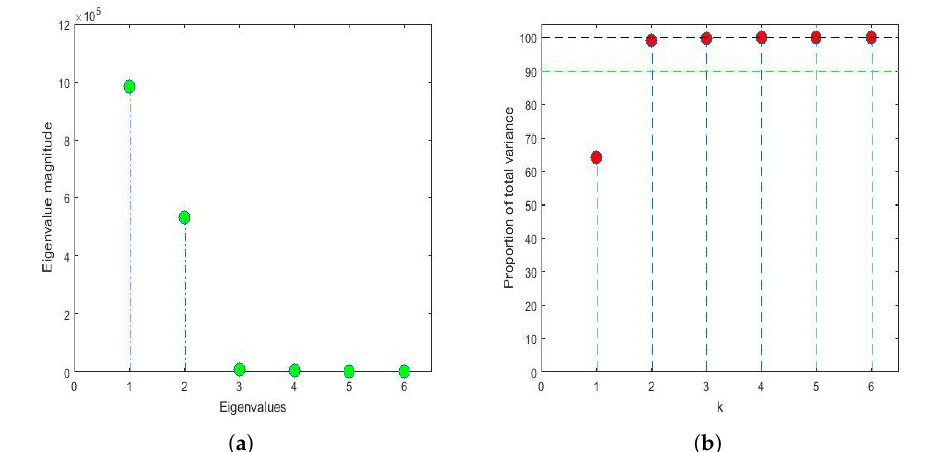
Figure 14. First eigenvalues and cumulative variance explained with the first eigenvalues. ( a ) First eigenvalues. ( b ) Proportion of total